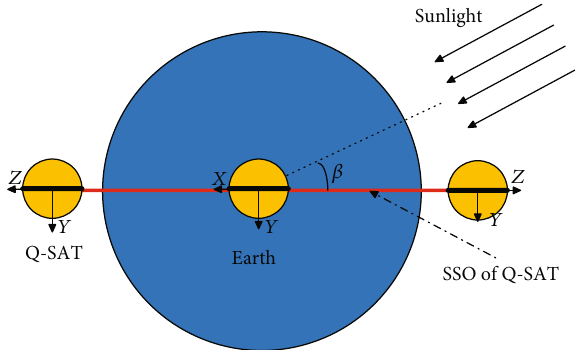
Figure 3: Orbit and condition of Q-SAT.